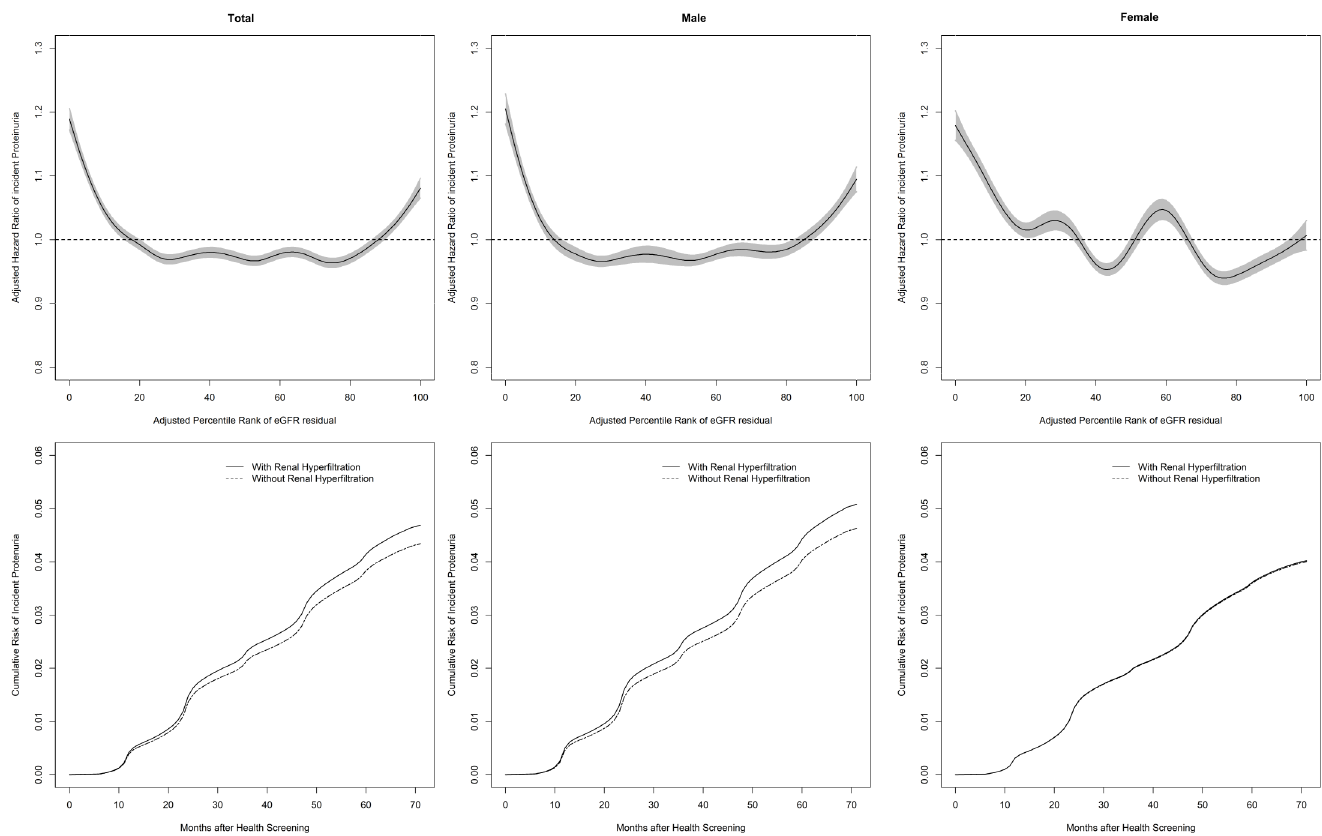
Fig 1. Association between renal hyperfiltration (RHF) with incident proteinuria. Upper panel. A reverse J-shaped association between baseline eGFR and the adjusted hazard ratio (aHR) of incident proteinuria. The age-, sex-, body size-, and history of diabetes and hypertension medication-adjusted percentile rank of baseline eGFR was associated with the aHR of incident proteinuria after adjustment for age, sex, smoking status, regular exercise, regular alcohol consumption, known history of diabetes and/or hypertension medication, body mass index, systolic blood pressure, fasting serum glucose, serum triglycerides, and serum high- density lipoprotein-cholesterol. The relationship between the percentile rank of baseline eGFR and the aHR of incident proteinuria was evaluated with a general additive model. The shaded area represents the 95% confidence interval. Lower panel. Association between RHF (see Methods for details) and aHR of incident proteinuria. The age-, sex-, body size-, and history of diabetes and hypertension medication-adjusted RHF was associated with the aHR of incident proteinuria after adjustment for age, sex, smoking status, regular exercise, regular alcohol consumption, known history of diabetes and/or hypertension medication, body mass index, systolic blood pressure, fasting serum glucose, serum triglycerides, and serum high-density lipoprotein-cholesterol.